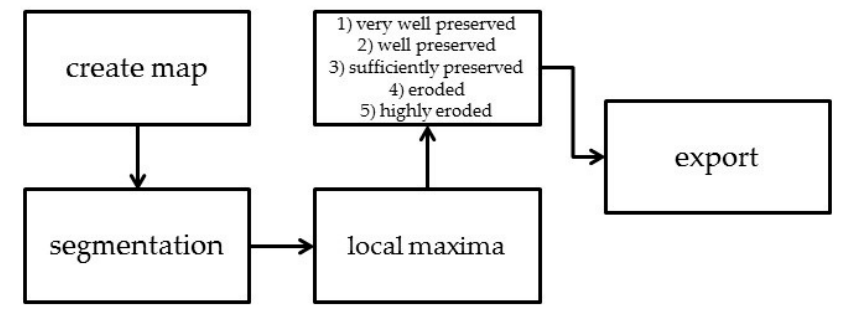
Table 7 . Overview of the classes that represent the Burial Mounds by their degree of erosion. Figure 13. Overview of the workflow in eCognition for the detection of Burial Mounds.